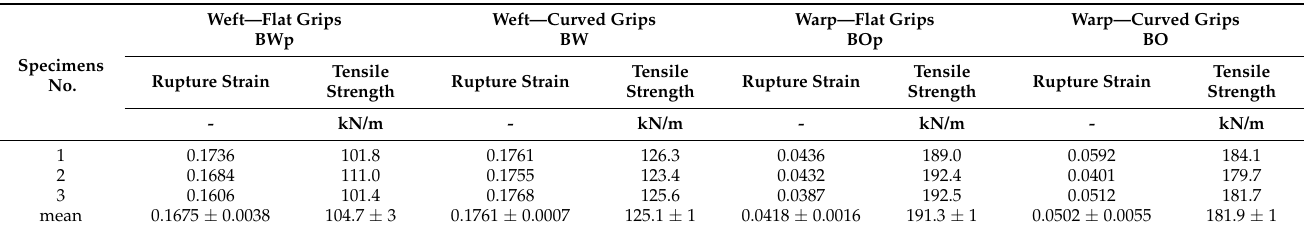
Table A4. Elongation at break and tensile strength—base specimens B type fabric.